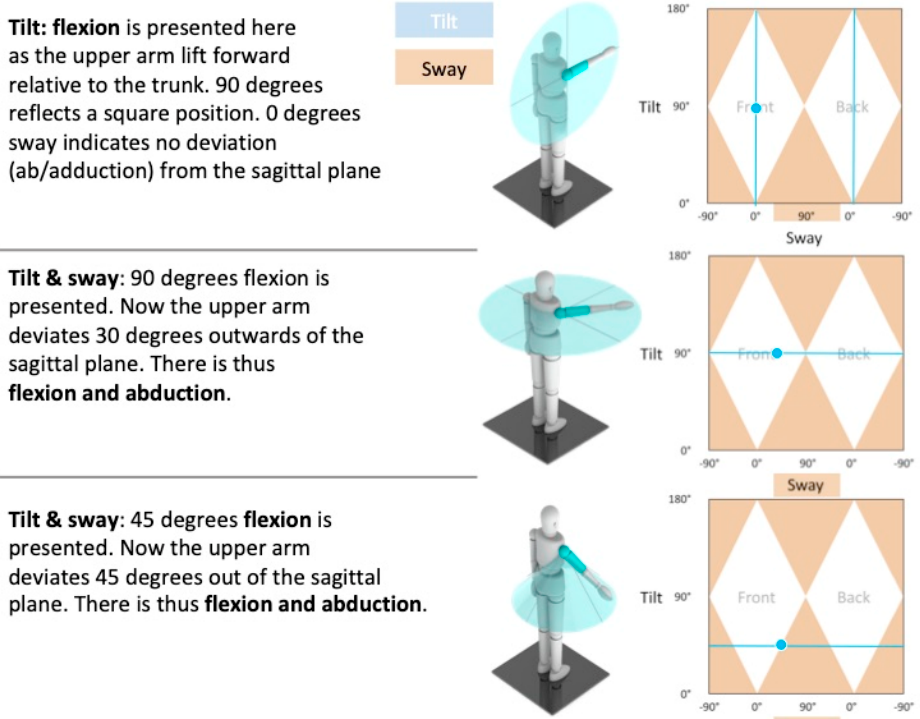
Figure 3. A graphical representation of sagittal and frontal plane movement of the SportsLapp